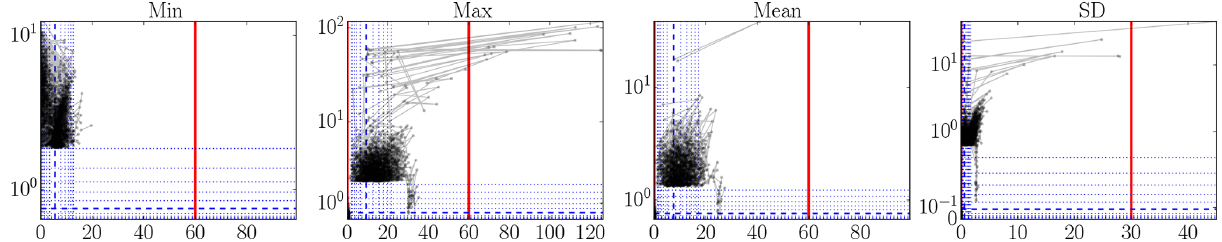
Figure 3. Illustrative plots for visually identifying outliers (see text for an explanation): OWEZ 21m NW ultrasonic anemometer horizontal wind speed data (ms − 1 ).